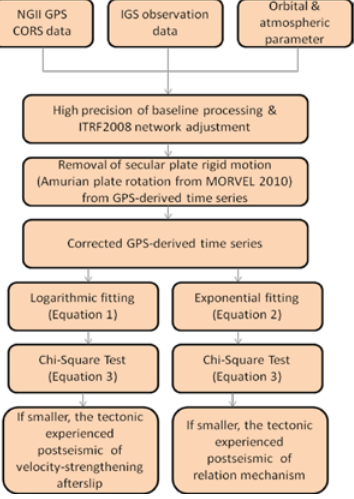
Figure 2. Work-flow of the work.